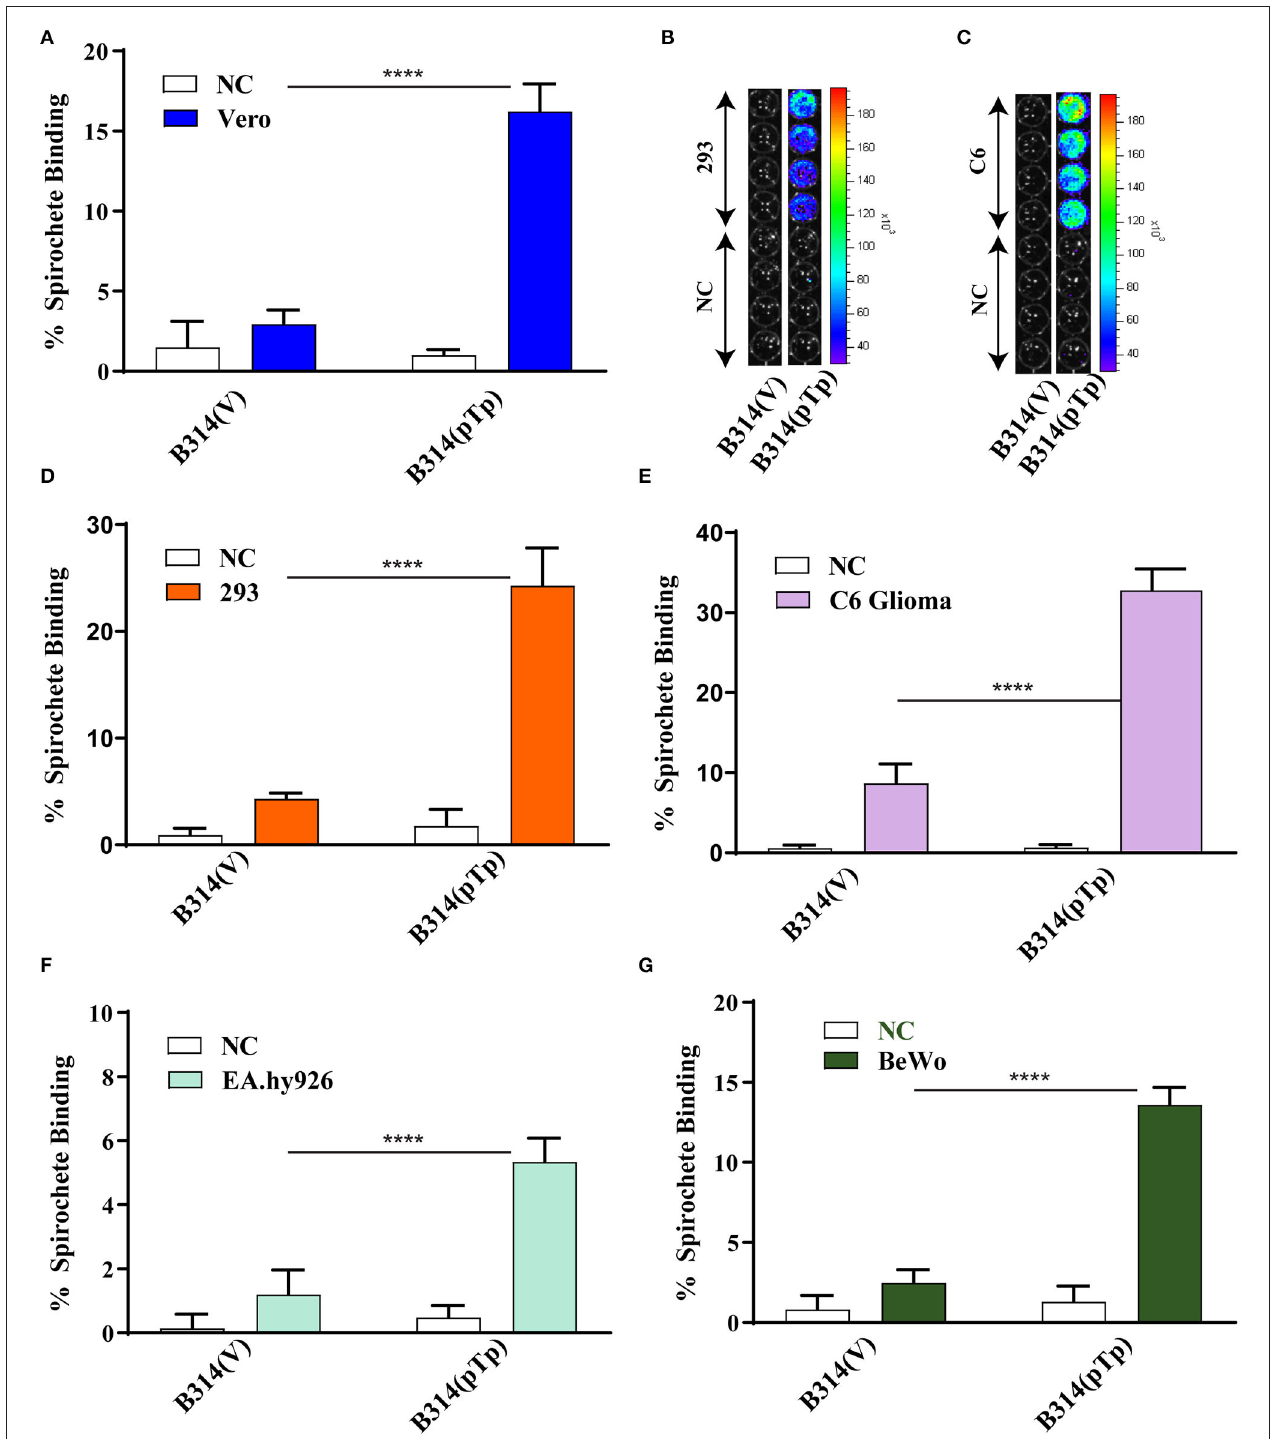
FIGURE 2 | Tp0954-expressing bacteria bind to various mammalian cell lines. (A,D) Radiolabeled Tp0954-expressing B314 and plasmid transformed control strains were used to evaluate binding to mammalian epithelial cell lines. B314(pTp-Bb) bound at a 5-fold higher level to Vero cells (A) , and 6-fold higher level to HEK293 (293) cells to (D) as compared B314 transformed by the empty pJSB175 vector, B314(V). (B,C) Binding assay conducted followed by washing and bioluminescence measurement confirmed that B314(pTP-Bb) binds at significantly higher level to 293 and C6 glioma cells. (E) B314(pTp-Bb) bound 3.6-fold higher level to the C6 glioma neuronal cells compared to control strain, while (F) B314(pTp-Bb) binds relatively weakly to endothelial EA.hy926 cell line. (G) Increase in binding of B314(pTp-Bb) was 3.5-fold higher than B314(V) to placental BeWo cell line. Statistically significant difference was determined by unpaired two-tailed t -test with Welch’s correction (**** P <